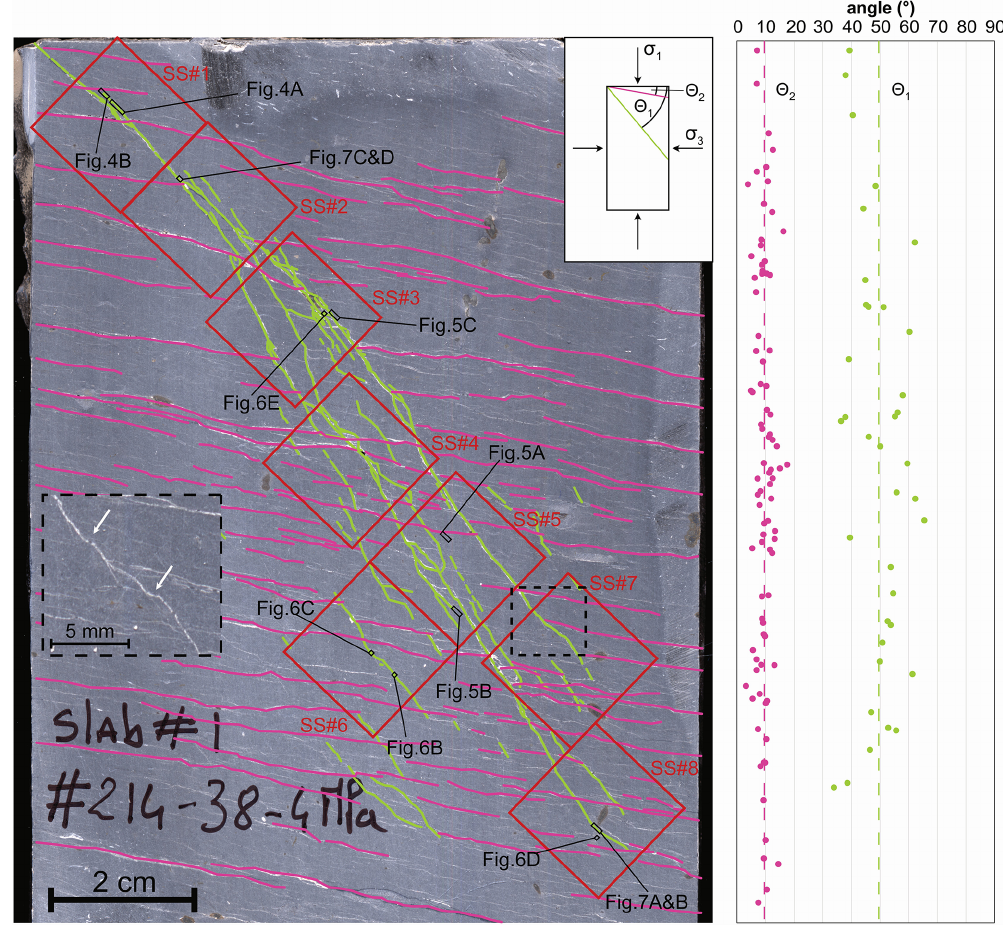
Figure 3. Macroscopic observations of the deformed sample. Red boxes indicate the location of the subsamples, and black boxes show the selected regions of interest for large mosaic maps at mesoscale and grain-scale magnifications. The macroscopically mapped fracture network showed two fracture sets: fracture set 1 (green) showed a branching pattern and had an average inclination angle of 49.5 ◦ ( (cid:50) 1 ), whereas the sub-horizontal fractures of fracture set 2 (pink) were inclined by 9.8 ◦ ( (cid:50) 2 ) with respect to horizontal. Angles of mapped fracture set 1 along the sample length showed a slight increase towards the centre of the sample; the angles of fracture set 2 were consistent throughout the entire